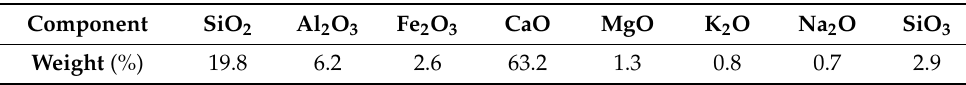
Table 2. Chemical compositions of CEM I 42.5R.